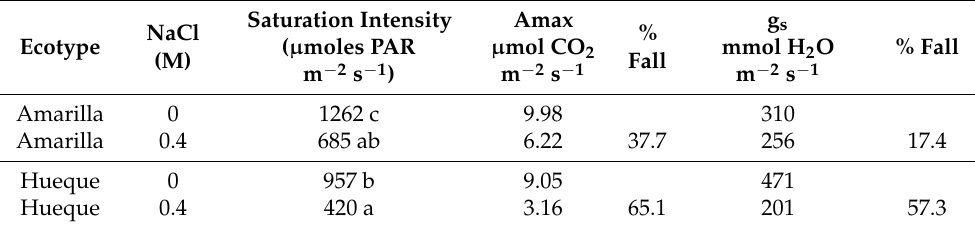
Table 2. The effect of salinity on different photosynthetic values of Amax and g s were obtained from curves of Figure 3 determined at the light saturation point and 350 µ L CO 2 L − 1 .